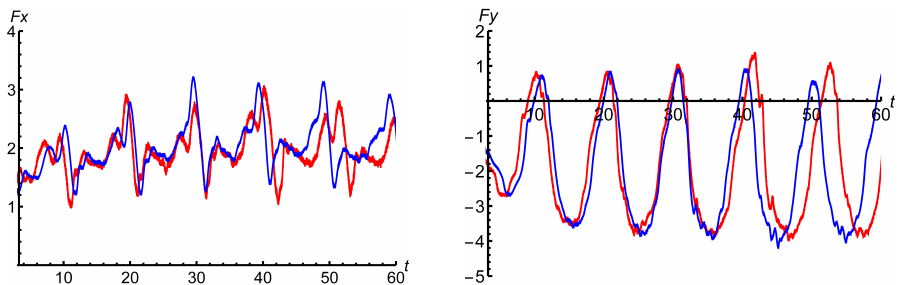
Figure 20. Unsteady lift and drag forces for an autorotating rotor; — VM2D , — OpenFOAM